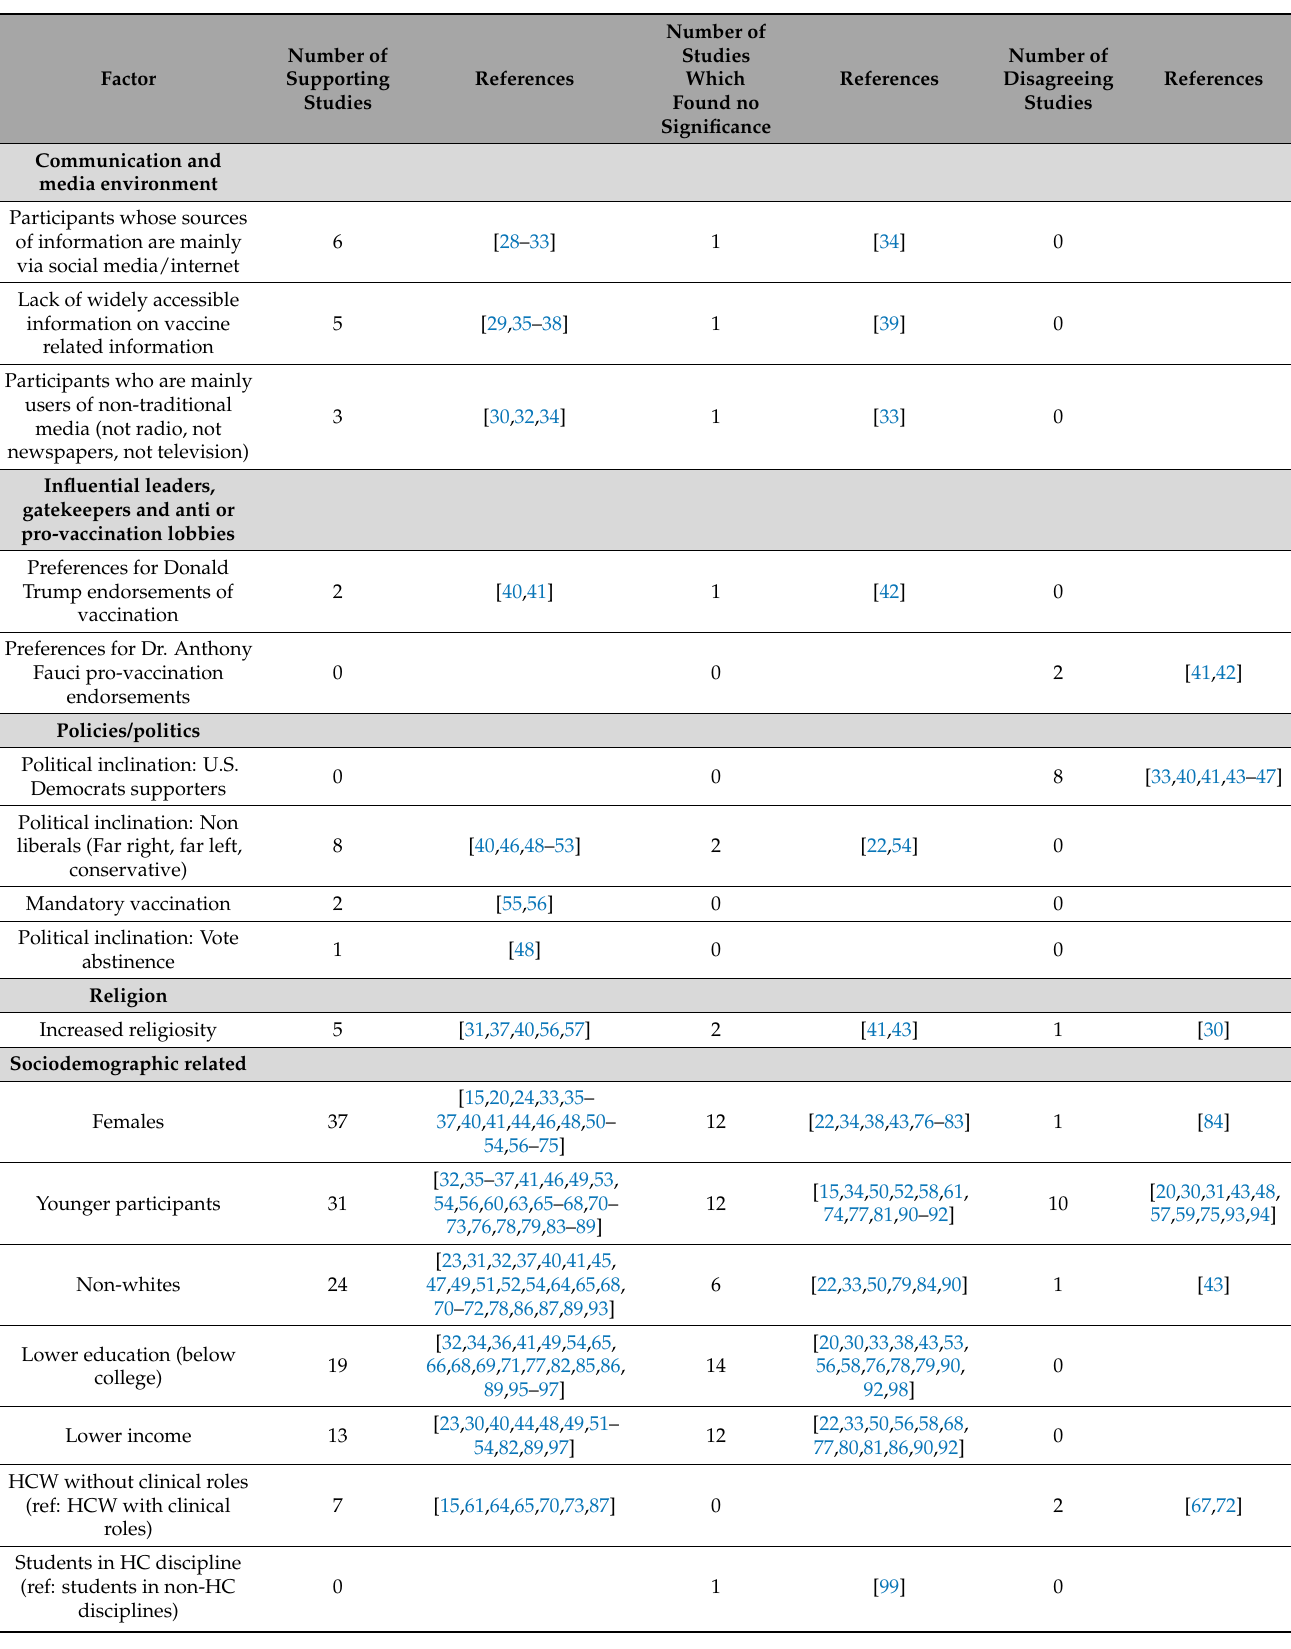
Table 2. Contextual determinants of vaccine related hesitancy in high-income countries or